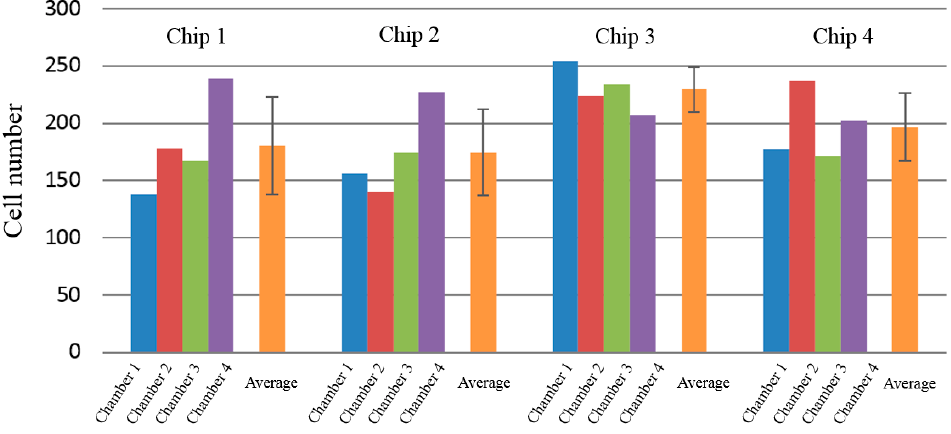
Figure 5. rBMSCs number uniformity in four microfluidic chamber.